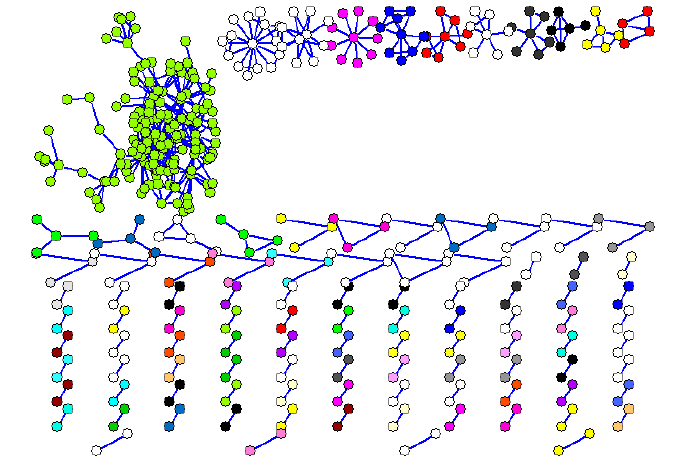
Figure 1. Content sharing graph for a directory on Windows